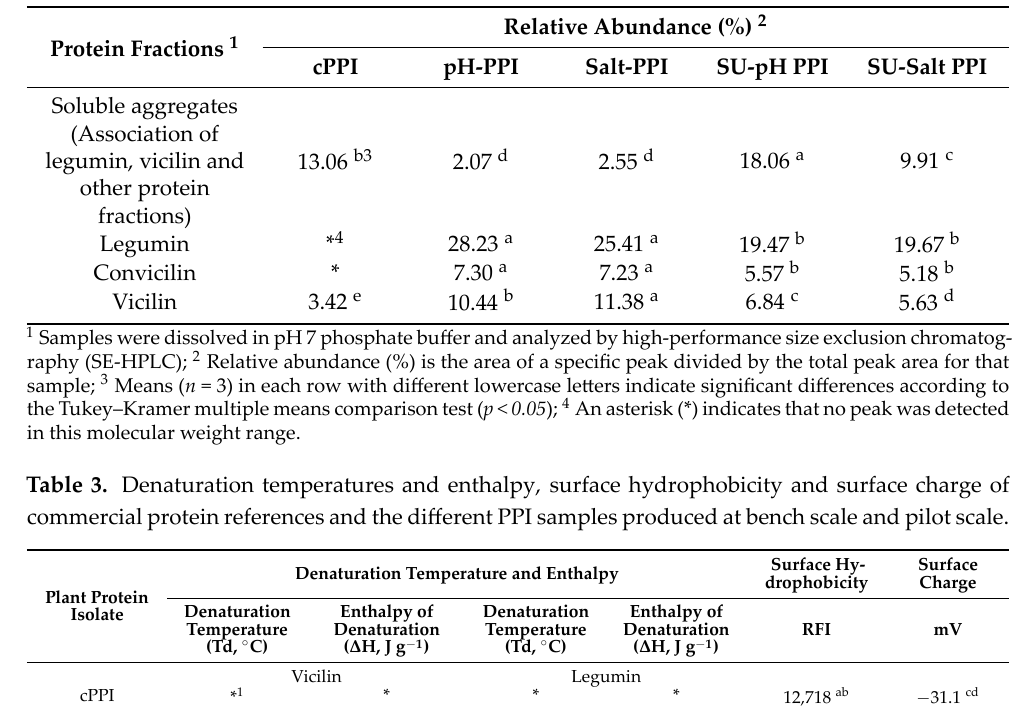
Figure 2. Percent relative abundance of different protein fractions in cPPI reference and PPI samples produced at bench scale and pilot scale. Samples were dissolved in pH 7 phosphate buffer and an‑ alyzed by SE‑HPLC. Bars distribution represents means of n = 3. Table 2. Relative abundance of soluble aggregates and functional proteins present in cPPI reference, and PPI samples produced at bench scale and pilot scale.